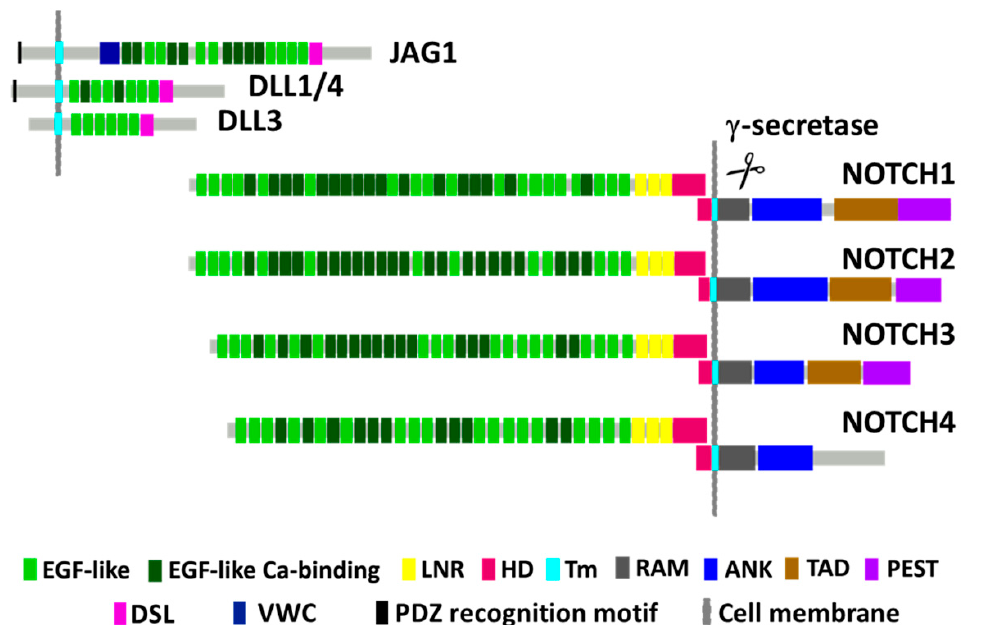
Figure 1. Schematic diagram of human NOTCH family member proteins and their ligands. NOTCH molecules are made as a larger precursor that gets cleaved into two polypeptides that rejoin through their hetero-dimerization (HD) domains at the cell’s surface during expression. The extracellular fragment is composed of multiple epidermal growth factor (EGF)-like repeats that mediate binding to NOTCH ligands; negative regulatory regions (LNRs) that prevent spontaneous activation of unbound NOTCH receptors; and a portion of the HD domain that binds the intracellular NOTCH fragment. Intracellular NOTCH fragments contain a small portion of the HD domain, the transmembrane domain (TM), the recombination signal binding protein (RBP)-J κ -associated molecule (RAM) domain, ankyrin repeats (ANK), a transcription activation domain (TAD), and a C-terminal proline-, glutamate-, serine-, and threonine-rich (PEST) sequence. The PEST domain interacts with FBXW7 to degrade activated intracellular NOTCH. Upon binding ligand (Jagged 1/2 (JAG1/2) or Delta-like ligand 1/3/4 (DLL1/3/4)) that is expressed on the surface of a neighboring cell, NOTCH receptors are activated in a juxtacrine manner to undergo conformational changes. These changes expose a cleavage site in the TM domain to a disintegrin and metalloproteinase (ADAM) proteases and finally to a γ -secretase complex. Intracellular NOTCH is liberated as activated intracellular NOTCH1 domain (ICN) that migrates to the nucleus and interacts with DNA binding proteins to regulate gene transcription of target genes. DSL, Delta/Serrate/Lag-2; VWC, von Willebrand factor type C domain; PDZ, PSD-95/Dlg/ZO-1.